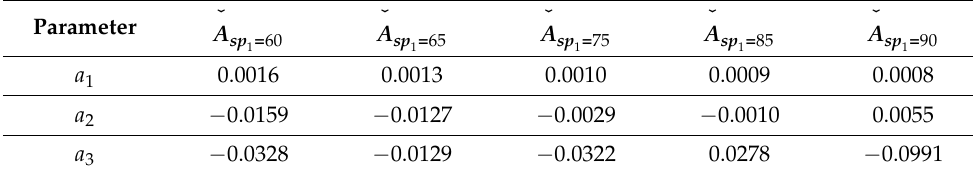
parameters’ values (procedure 3). 1